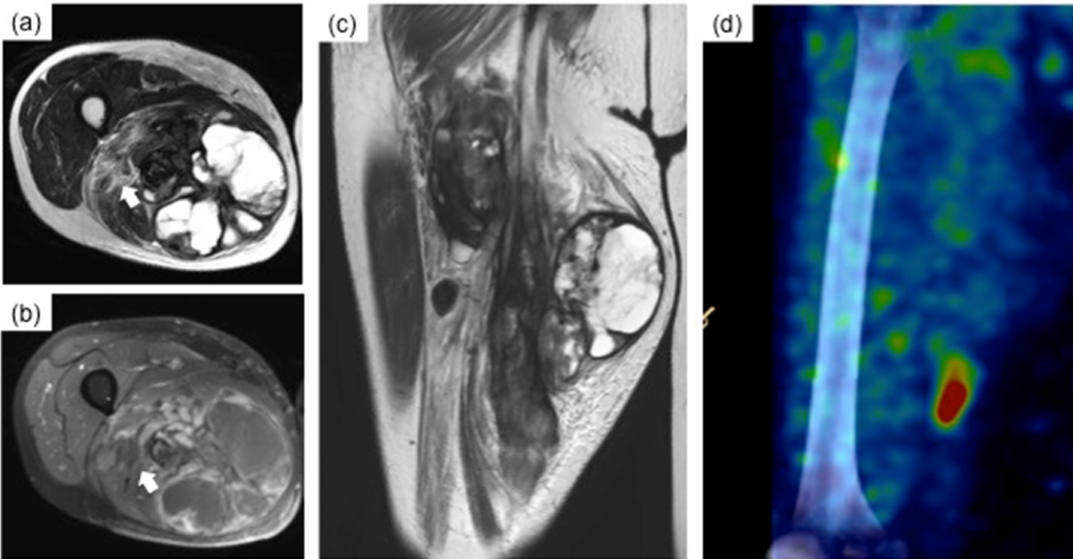
Figure 3. Images after five cycles of radio-hyperthermo-chemotherapy. ( a – c ) indicate the cystic and degenerative changes of the tumor. Despite the subtle change in the length of the tumor (12 cm × 10 cm × 25 cm), contrast with gadolinium was only observed in the peripheral area of the cyst, indicating a good response to neoadjuvant therapy. 201 Thallium scintigraphy revealed attenuation of tracer uptake (mean TBR = 3.2 on early phase, ( d